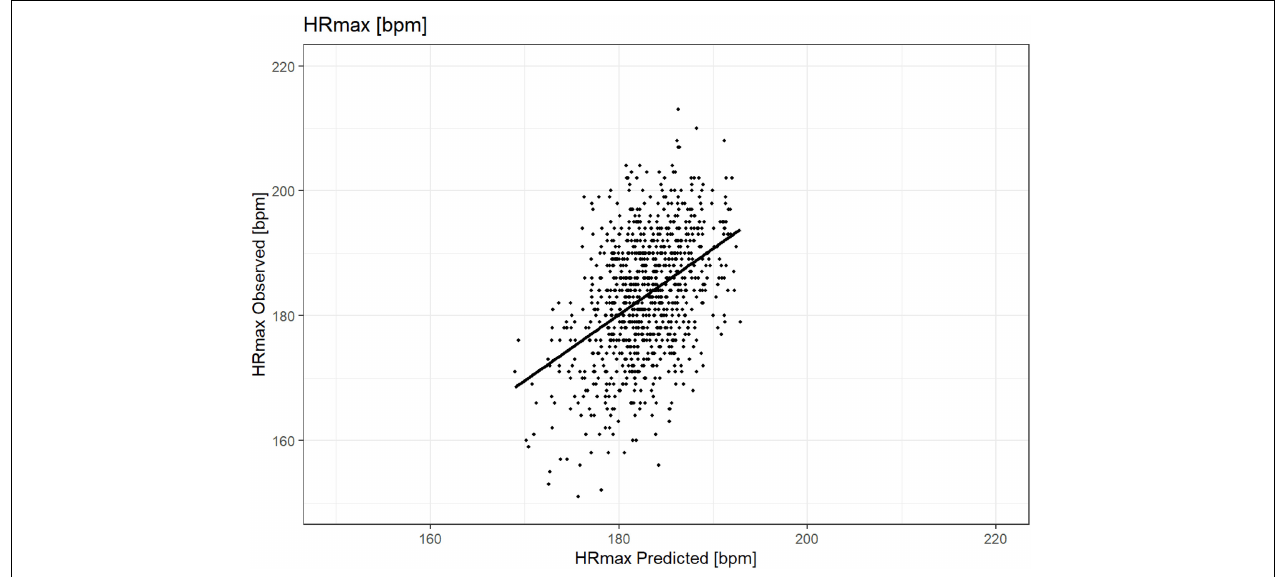
FIGURE 3 | Graph of observed (y-axis) vs. predicted (x-axis) HRmax (bpm) in the stepwise regression